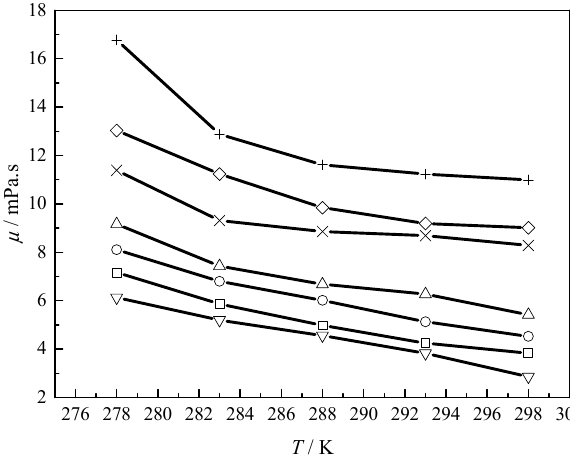
Figure 3. Viscosity of ( ▽ ) diesel oil and water-in-oil emulsion with AA-3 for a water cut of ( □ ) 5 vol %; ( ○ ) 10 vol %; ( △ ) 15 vol %; (×) 20 vol %; ( ◊ ) 25%; (+) 30%. Lines are provided to guide the eye.